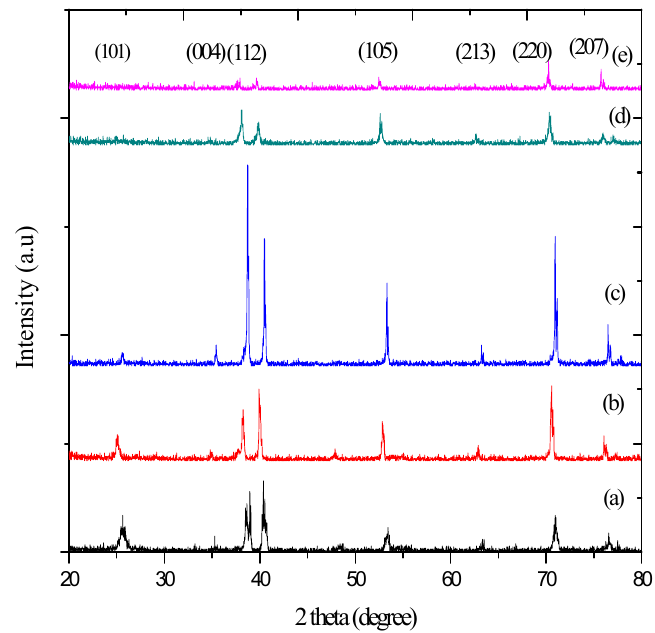
Figure 5. X ‐ ray Diffraction (XRD) patterns of CuTiO 2 photocatalyst labelled ( a ) Cu ‐ 00; ( b ) Cu ‐ 01; Figure 5. X-ray Diffraction (XRD) patterns of CuTiO 2 photocatalyst labelled ( a ) Cu-00; ( b ) Cu-01; ( c ) Cu-02; ( d ) Cu-03; and ( e ) ( c ) Cu ‐ 02; ( d ) Cu ‐ 03; and ( e ) Cu ‐ 04.